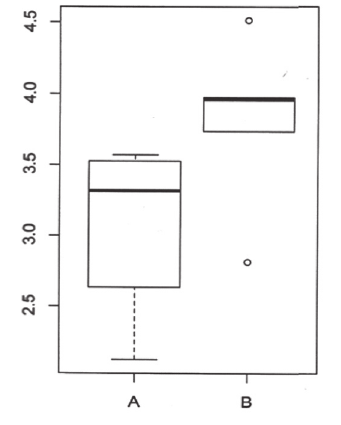
Figure 3 - Turkey Multiple Comparison of Means (Box Plot) for testis-organ weight showing the mean levels at 3.3 g in group A and 4.0 g in group B as indicated by the bold transverse bands.